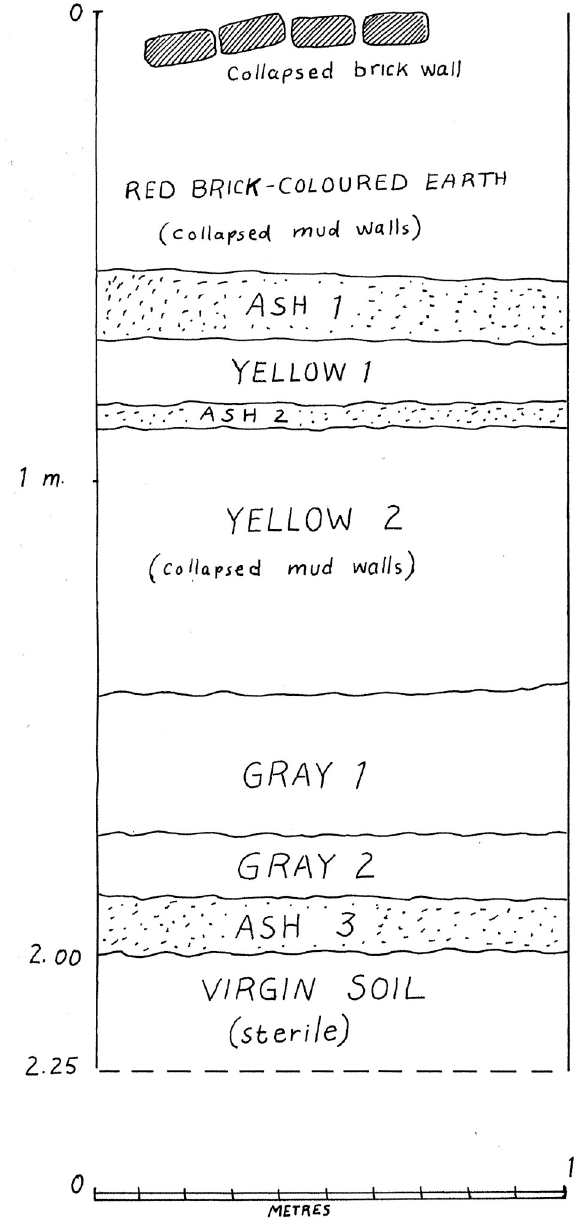
Fig 14. Stratigraphic profile of the 1965 test pit in the ‘west cut’ (by P.E.L. Smith).